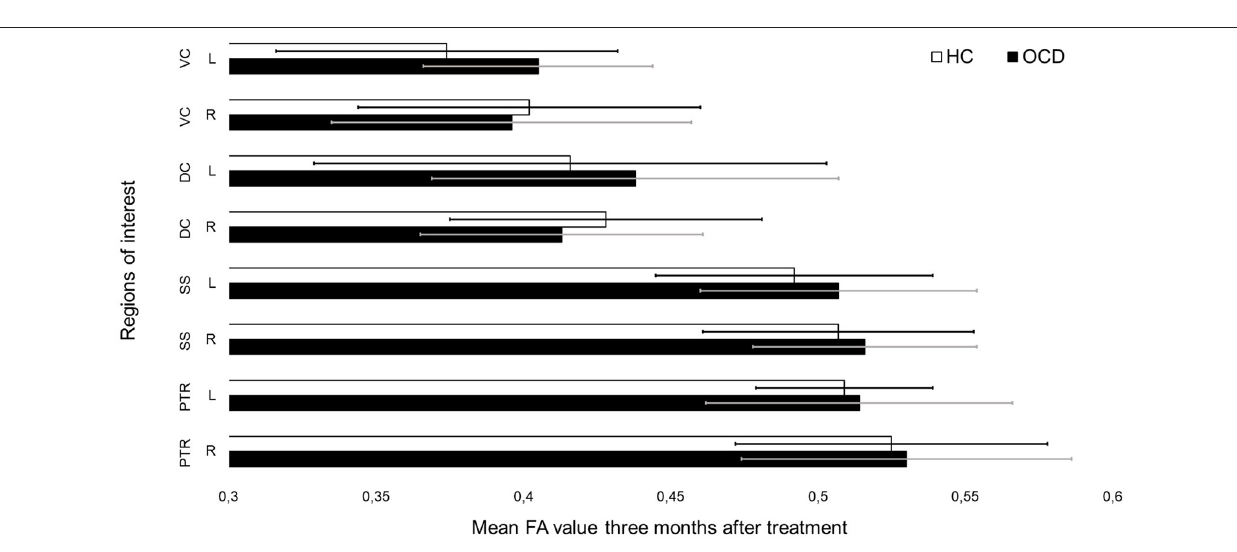
FIGURE 4 | Mean fractional anisotropy (FA) values for each region of interest in patients and controls after